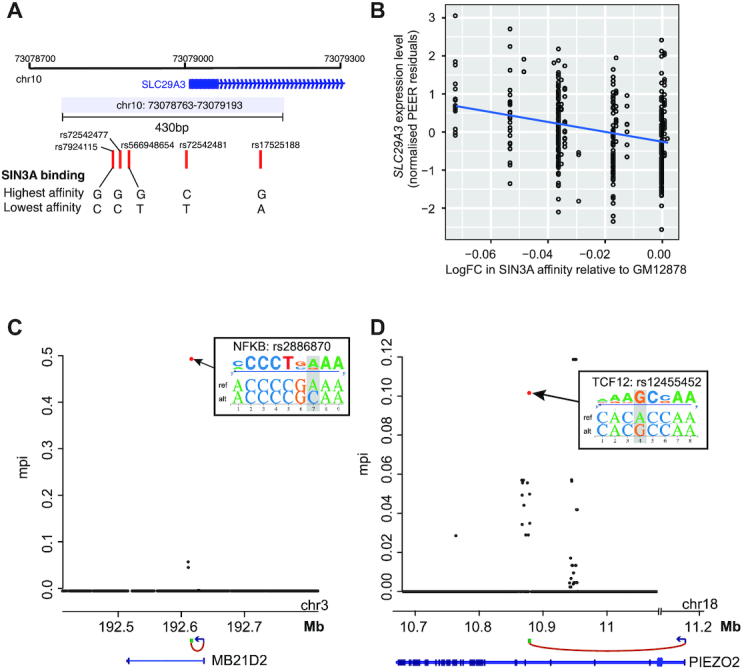
Unthresholded approach for detecting TF binding affinity CRM variant associations with gene expression and their validation using GUESSFM. (A) Example of a CRM with multiple SNPs affecting the affinity for the same TF, SIN3A. (B) Association between log-fold change in CRM affinity for SIN3A (relative to the highest affinity allele observed in GM12878) and mRNA level (normalized PEER residuals) of the connected gene, SLC29A3 (gene-level FDR adjusted P-value = 1.60 × 10−4, β = −0.14). (C, D) Examples of loci, whereby the SNP predicted to have the strongest impact on a CRM’s binding affinity for a given TF has been fine-mapped as a potentially causal variant driving the locus’s association with the expression of a physically connected target gene (GUESSFM \documentclass[12pt]{minimal}
\usepackage{amsmath}
\usepackage{wasysym}
\usepackage{amsfonts}
\usepackage{amssymb}
\usepackage{amsbsy}
\usepackage{upgreek}
\usepackage{mathrsfs}
\setlength{\oddsidemargin}{-69pt}
\begin{document}
}{}${\rm mppi}\gg 0.001$\end{document}). (C) eGene: MB21D2; eQTL rs2886870, predicted to affect NFKB binding affinity. (D) eGene: PIEZO2; eQTL rs12455452, predicted to affect TCF12 binding affinity. See insets for the effects of the SNPs on the respective TF's PWM match.